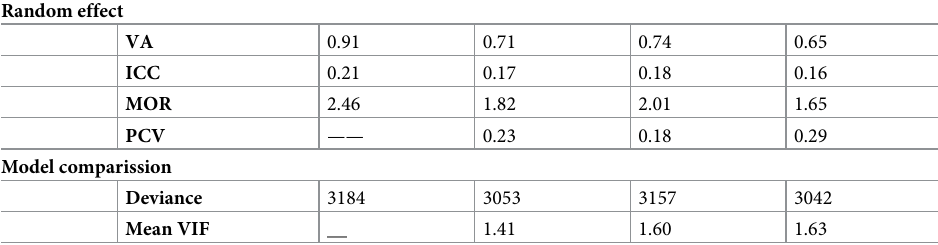
Table 3. Results from a random intercept model (a measure of variation) for utilization of deworming among pregnant women at cluster level by multilevel logistic regression analysis, EDHS